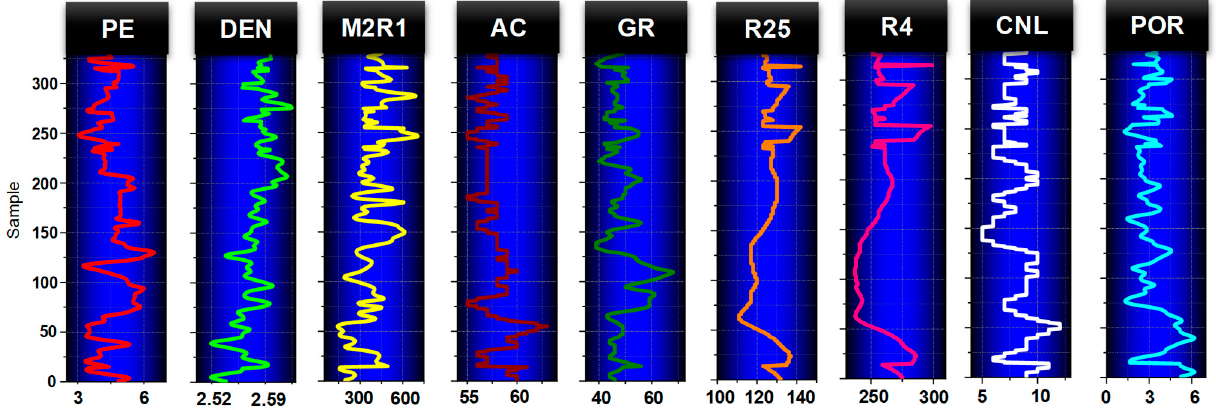
Figure 2. Flow chart of optimizing Elman neural network based on WOA meta heuristic algorithm. Table 1. The full name of the abbreviation mentioned in the text.